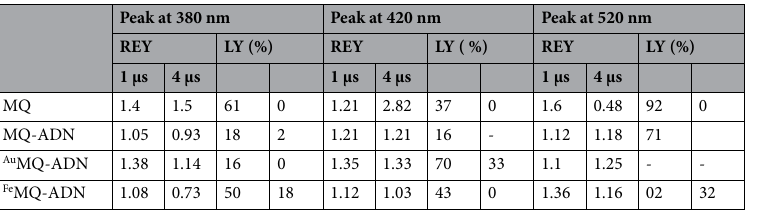
Table 2. Radical escape yield (REY) at 1 μs and 4 μs time delay and Lifetime Yield (LY) at 380, 420, and 520 nm, respectively.